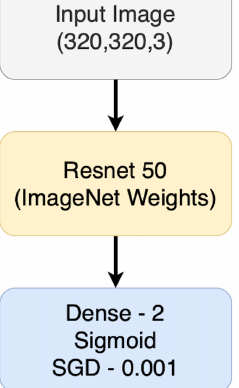
Figure 3. Network Architecture.